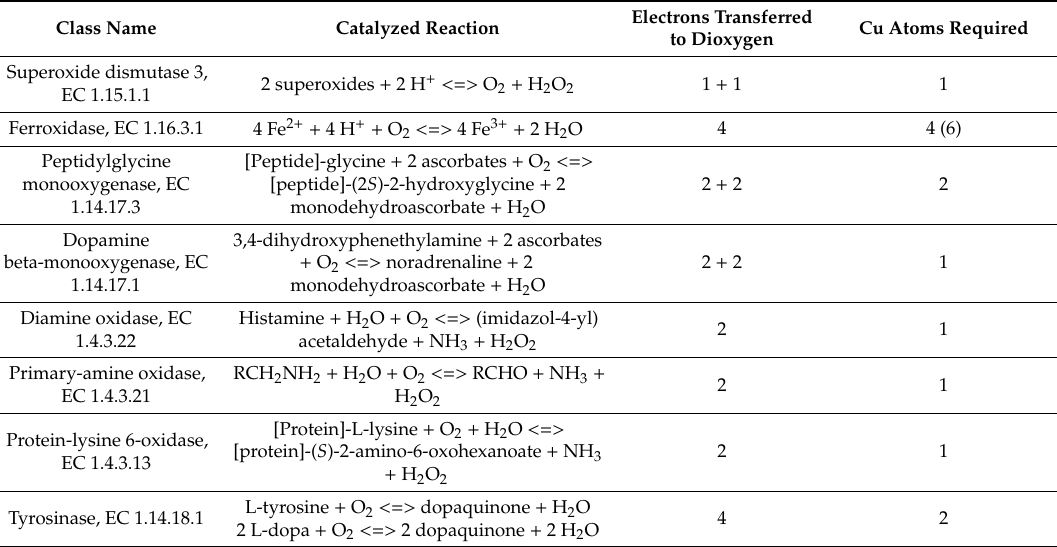
Table 1. Catalyzed reactions by cuproenzyme group (source: